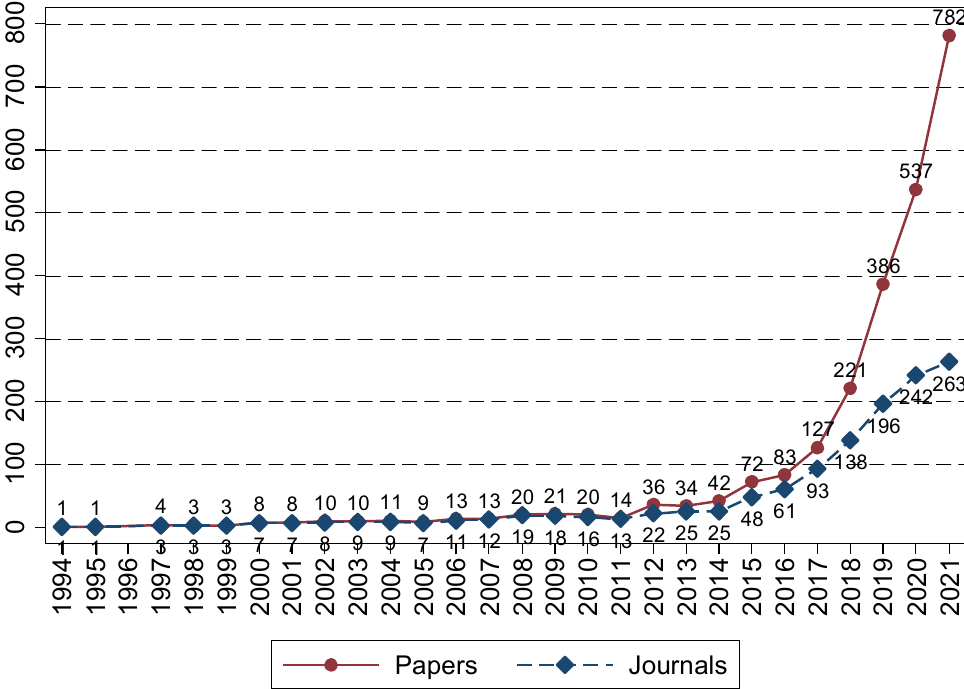
Figure 2. Frequency distribution of papers and journals analyzed by year of publication. Table 1. Journals with twenty or more papers from 1994 to